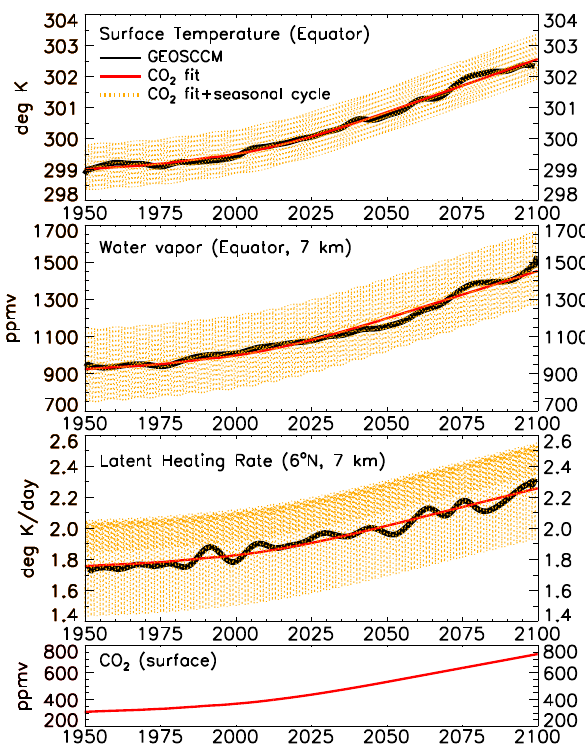
Fig. A1. Time series for 1950–2100 of zonally averaged and desea- sonalized surface temperature, water vapor mixing ratio, and latent Figure A1. Time series for 1950–2100 of zonally averaged and deseasonalized surface temperature, heating from the GEOSCCM (black curves), and the corresponding water vapor mixing ratio, and latent heating from the GEOSCCM (black curves), and the corresponding fits to the surface CO 2 boundary condition (red curves) for the lo- fits to the surface CO 2 boundary condition (red curves) for the locations indicated. Inclusion of the cations indicated. Inclusion of the seasonal cycle to the CO 2 fits is seasonal cycle to the CO 2 fits is depicted by the orange shading. The surface CO 2 boundary condition depicted by the orange shading. The surface CO 2 boundary condi- is shown in the bottom panel. See text for details. tion is shown in the bottom panel. See text for